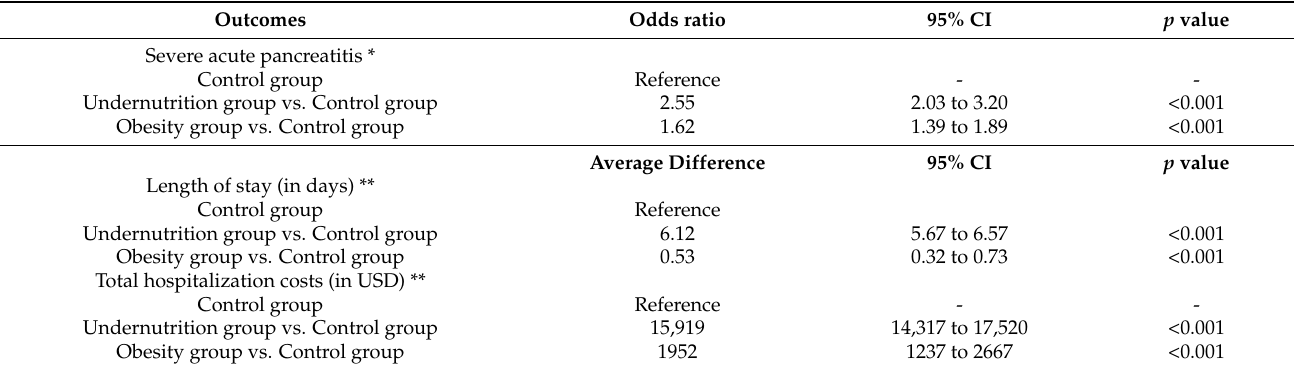
USD—United States dollar. * Please refer to supplemental Table S2 for the multiple logistic regression model with severe acute pancreatitis as outcome variables. ** Please refer to supplemental Table S3 for the multiple linear regression models with length of stay and total hospitalization costs as outcome